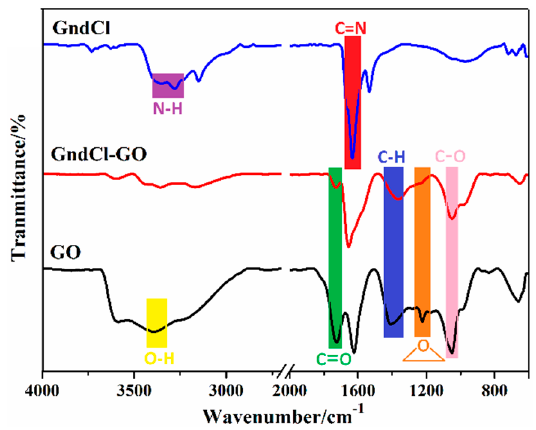
Figure 1. FT-IR spectra of GndCl, GO and GndCl-GO.